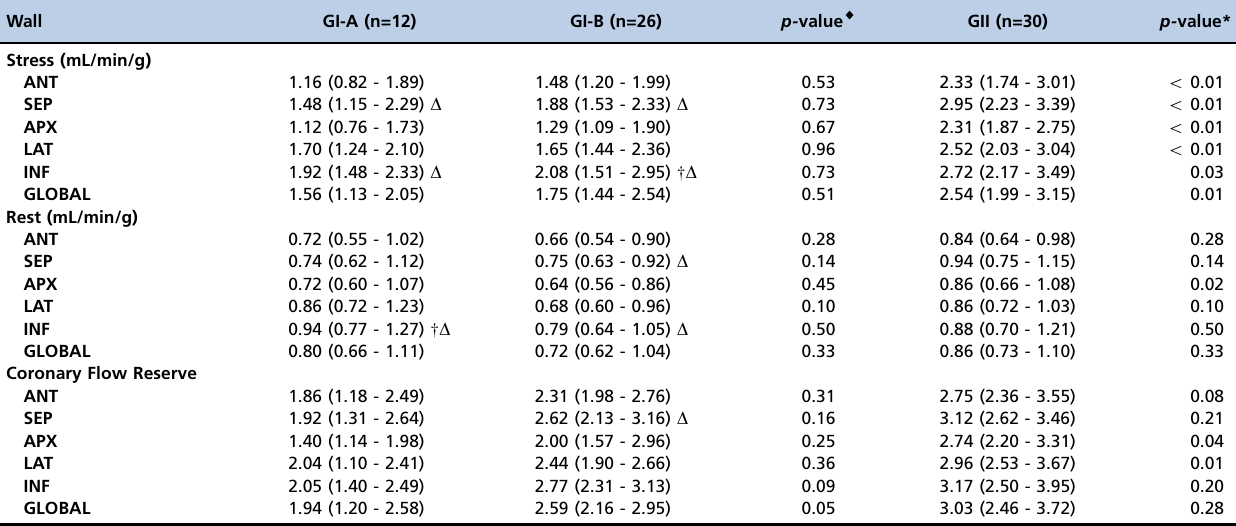
Table 3 - Results of the comparison of global and regional 82 Rb-PET myocardial blood flow among groups. Wall GI-A (n=12) GI-B (n=26) p- value ~ GII (n=30) p- value* Stress (mL/min/g)